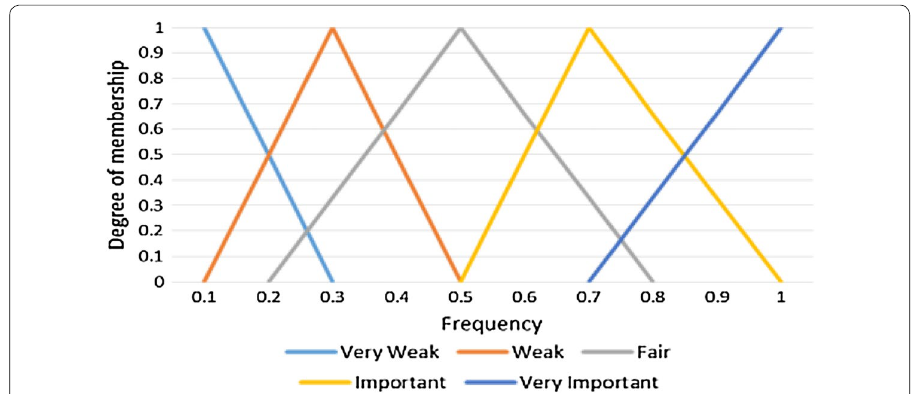
Fig. 2 Membership functions for levels of anomaly attributes